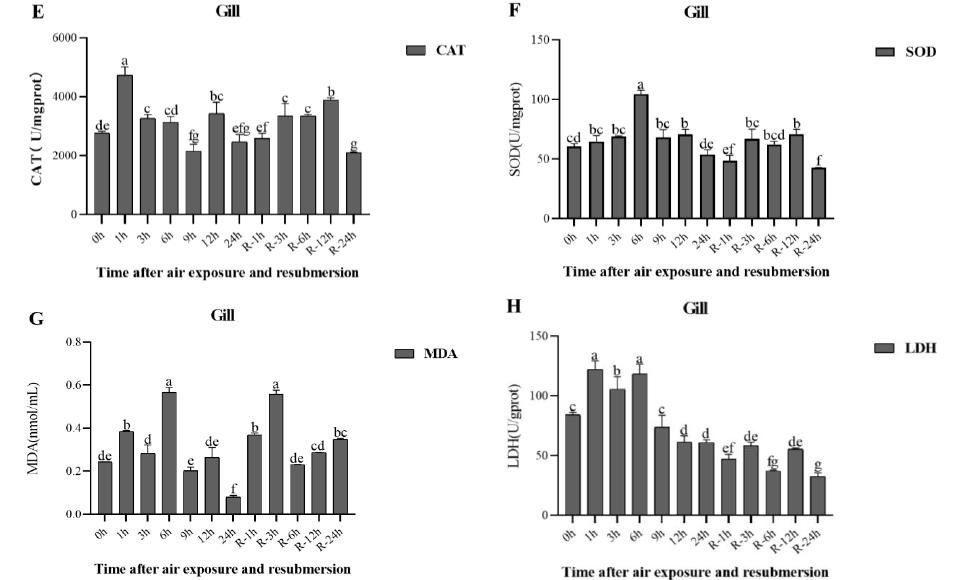
Figure 4. CAT activity ( E ), SOD activity ( F ), MDA content ( G ), and LDH activity ( H ) in the gill of P. clarkii after air exposure for 0 h, 1 h, 3 h, 6 h,9 h, 12 h and 24 h, including re-submersion for R-1 h, R-3 h, R-6 h, R-12 h, and R-24 h. Different letters show significant differences between different expo- sure times in the same tissue ( p < 0.05).